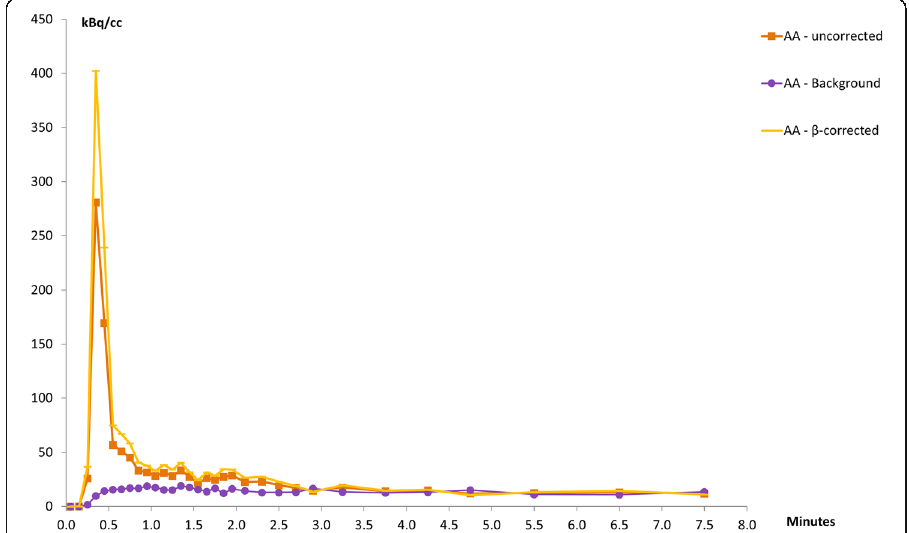
Fig. 7 Representative time activity curves from the abdominal aorta and the aortic background from one of the study